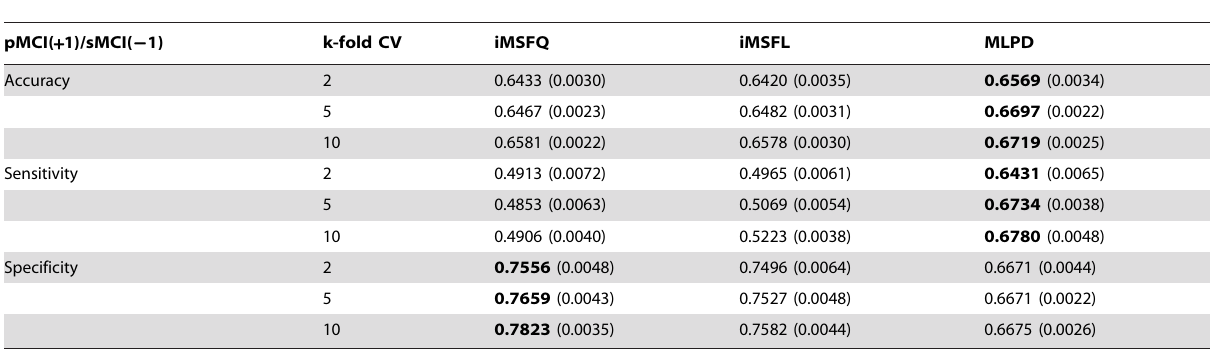
Table 2. Classification performance of MLPD and iMSF using incomplete MRI and PET.